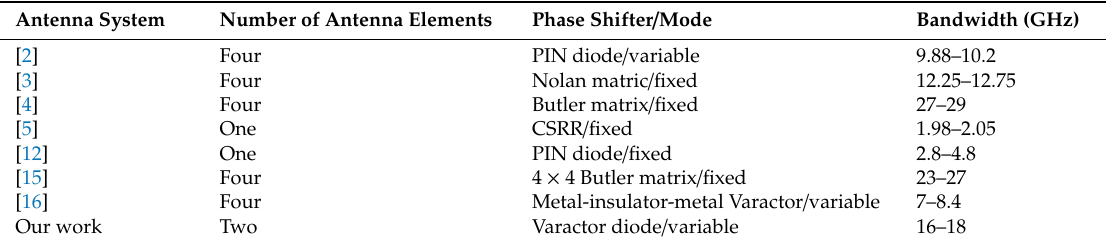
Table 4. Comparison of seven recent beam steering antenna systems with our design in terms of gain, scan range, and